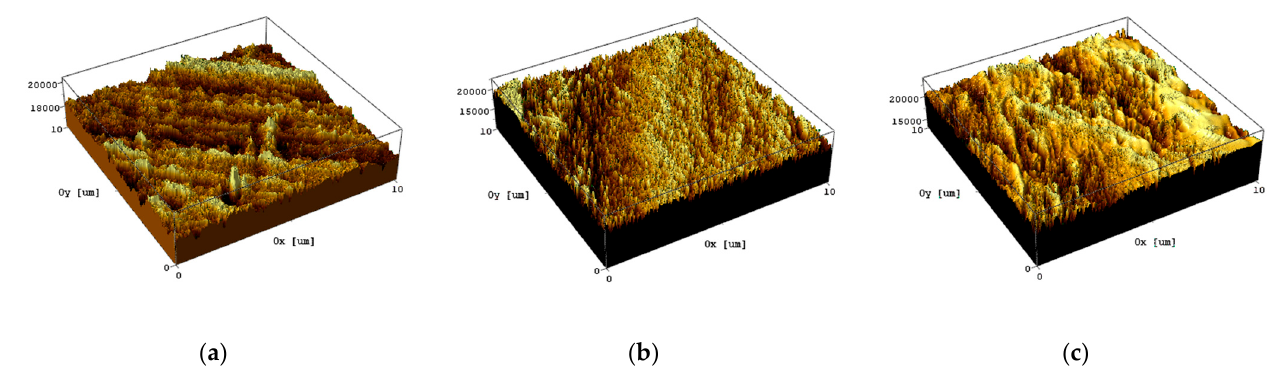
Figure 2. 3D surface morphology of pristine ( a ) and irradiated PEEK: ( b ) 200 kGy; ( c ) 400 kGy.